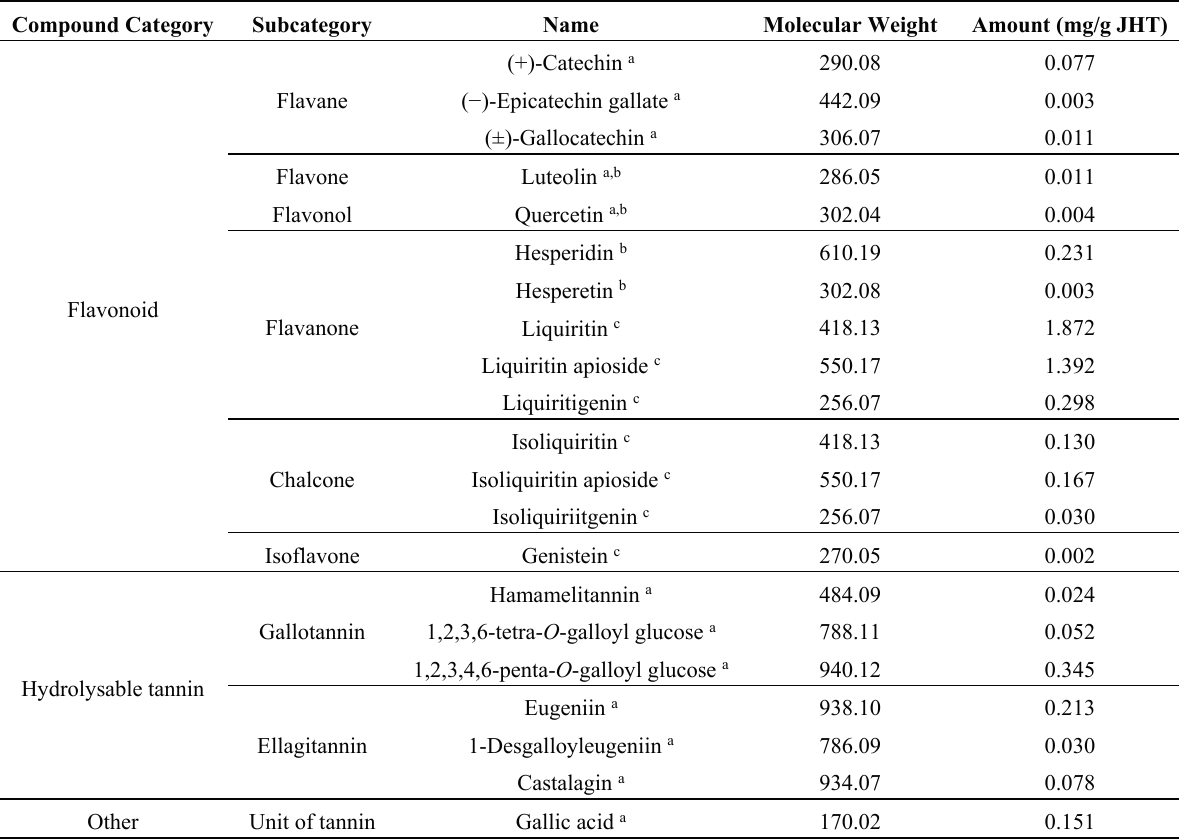
Table 1. Contents of polyphenols in JHT